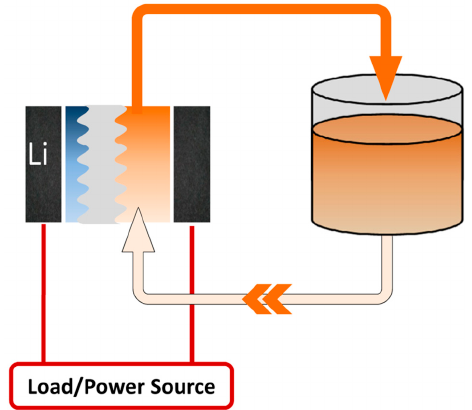
Figure 3. Illustration of a lithium hybrid flow battery. The anodic side consists of lithium metal and organic electrolyte, while the catholyte is circulated.